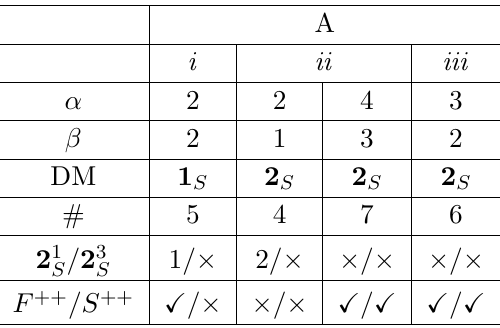
Table 2. Realizations of Class 1.a of (cid:12)gure 1. For each set of SU ( 2 ) L quantum numbers (roman numerals) and Z 2 assignments (capital letters A, B, C) we give the hypercharge in terms of (cid:11) and (cid:12) parameters, the DM candidates, the number of BSM particles (#), the number of 2 1 present as well as the existence (or not) of doubly-charged fermions ( F ++ ) and doubly-charged scalars ( S ++ ). The symbol X ( (cid:2) ) means present (absent) while the symbol (cid:3) , if present in the DM row, means mixing between 1 0 and 2 1 . The SU ( 2 ) L , Z 2 and U ( 1 ) Y assignments are given in table 1. S S